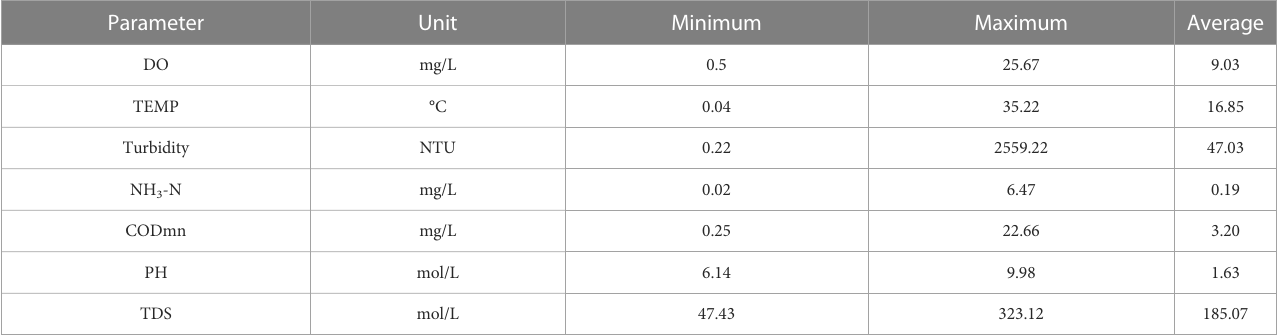
TABLE 1 River water quality data